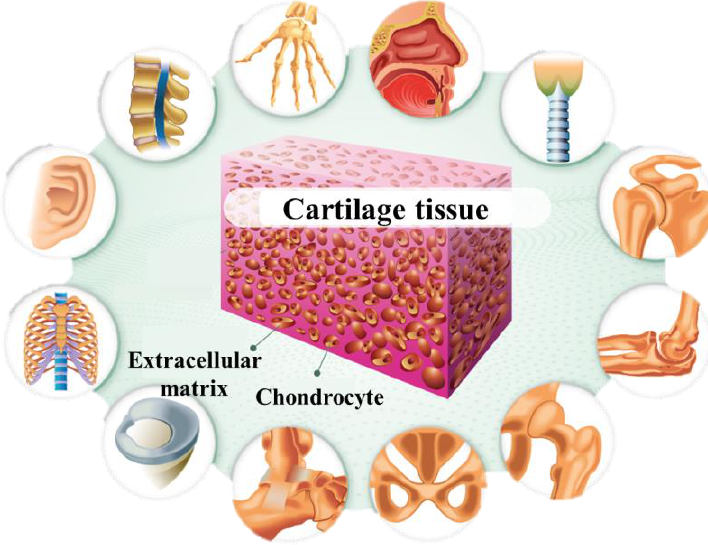
Figure 2. Schematic of the cartilage tissue structure. (a) Collagen (type II) and chondrocytes are two major components of cartilage tissue, the application of cartilage tissue in different parts of the human body (reproduced with permission from [42]).